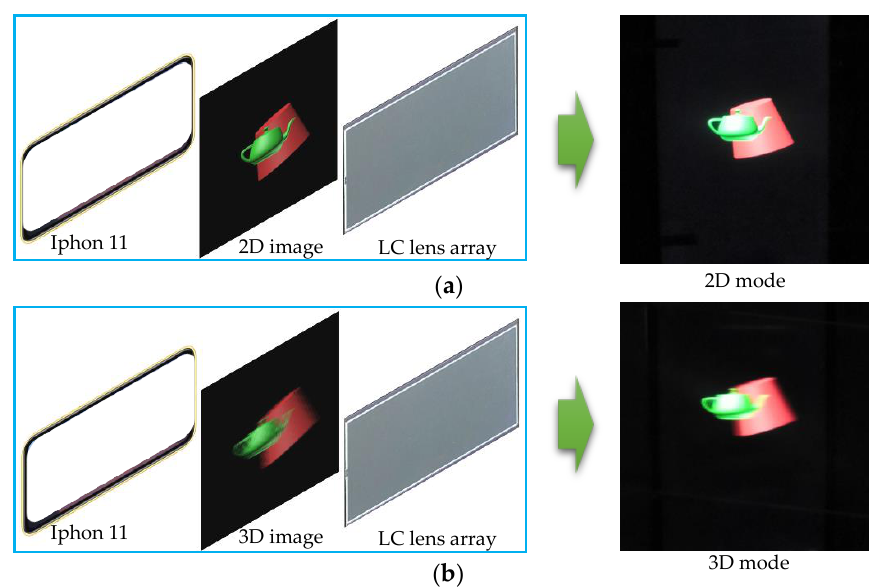
Figure 8. ( a ) 2D image with the cylindrical LC lens array at voltage-off state and ( b ) 3D image with the cylindrical LC lens array at voltage-on state.